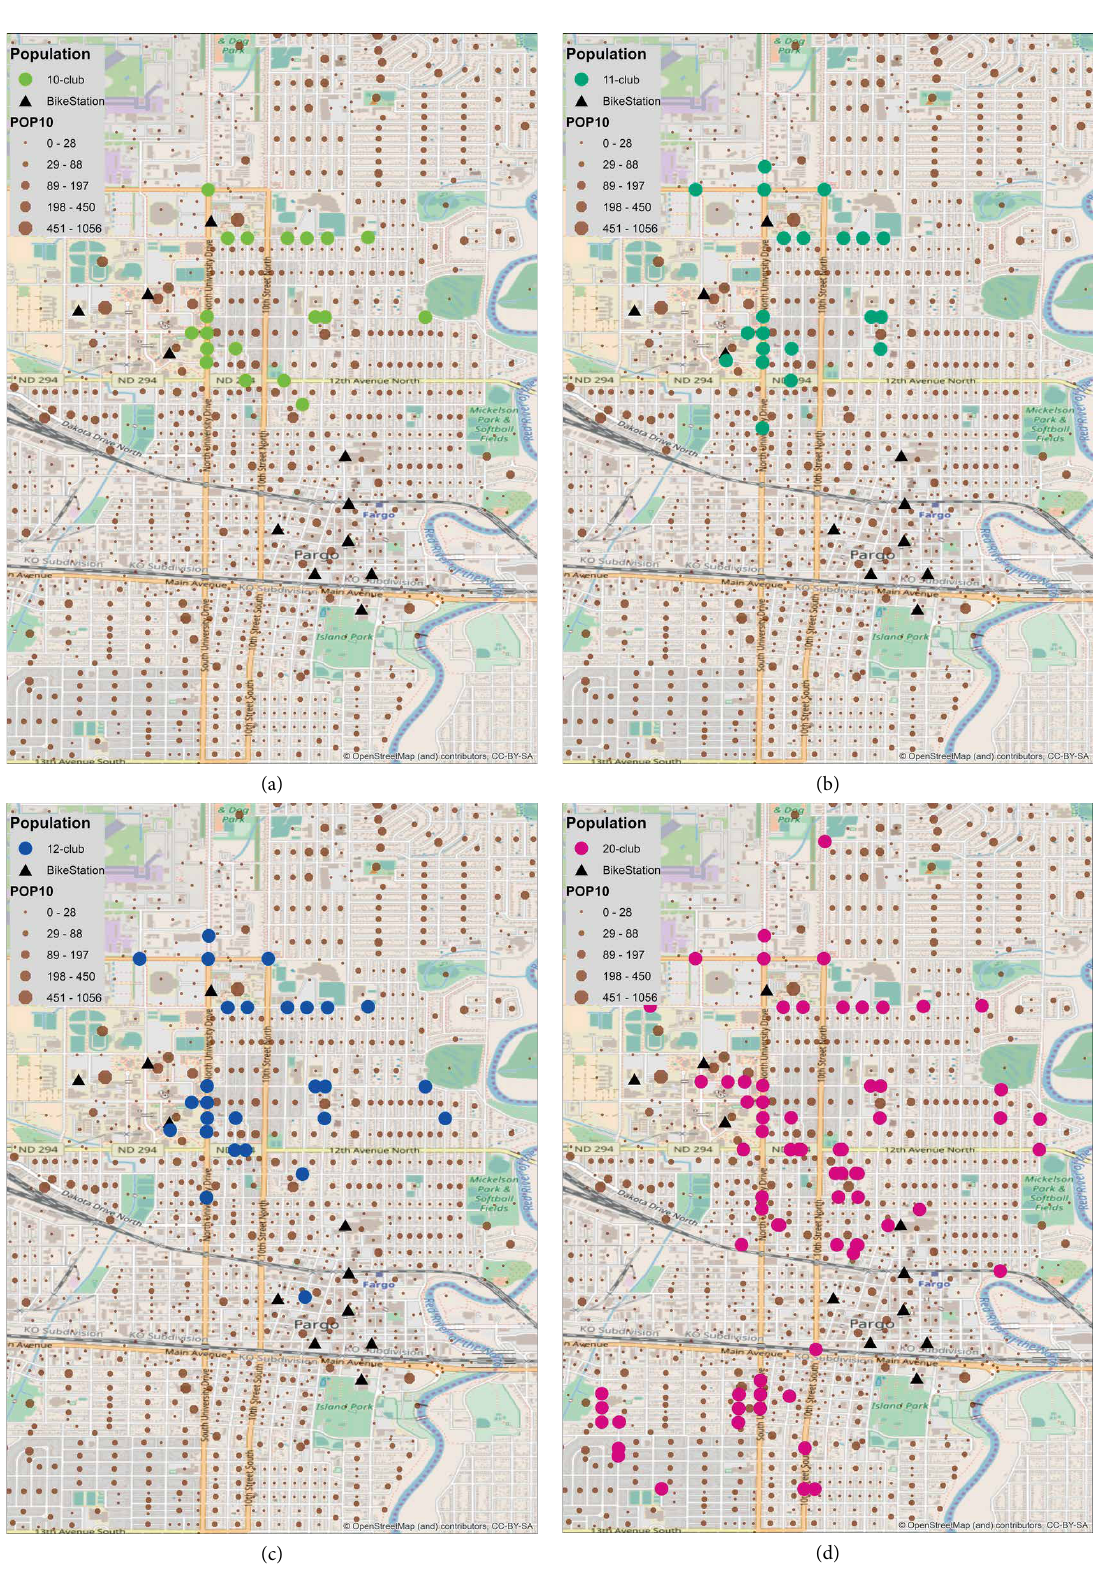
Figure 8: The 𝑘 -clubs obtained from the heuristic for the city of Fargo. The results are for 𝑘 = 10, 11, 12, and 20 in the top left, top right, bottom left, and bottom right,